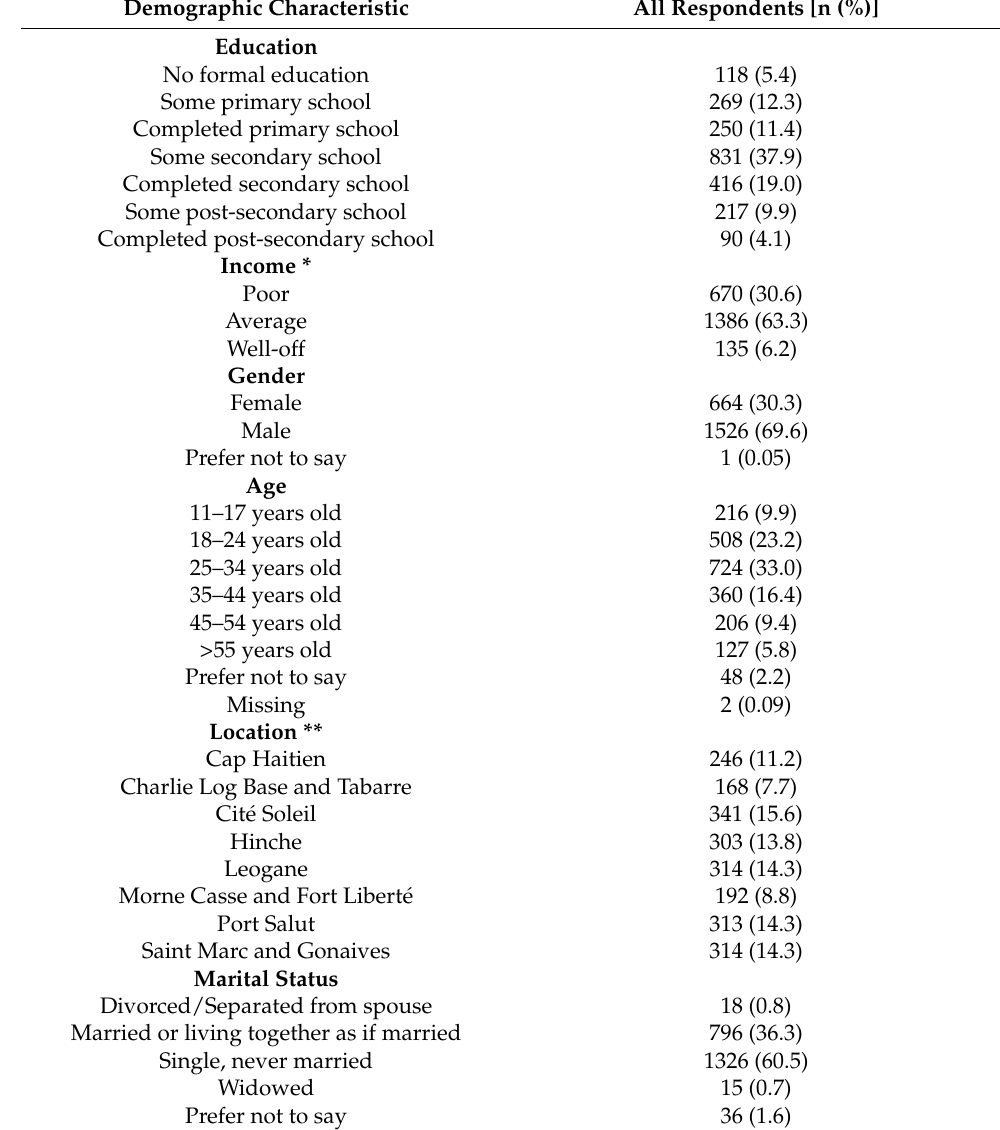
Table 1. Participant demographic